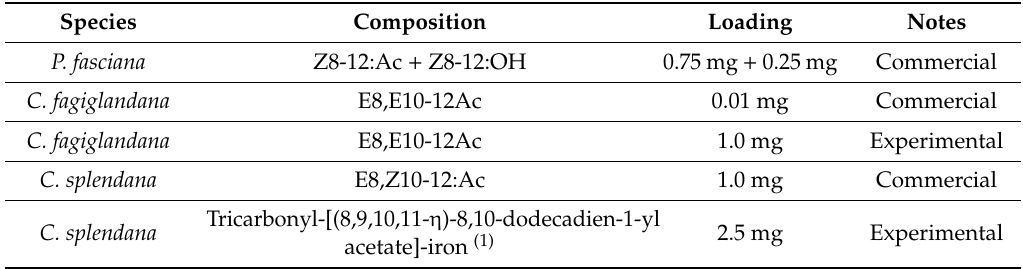
Table 1. Sexual pheromone lures tested in northwestern Italy for monitoring Pammene fasciana